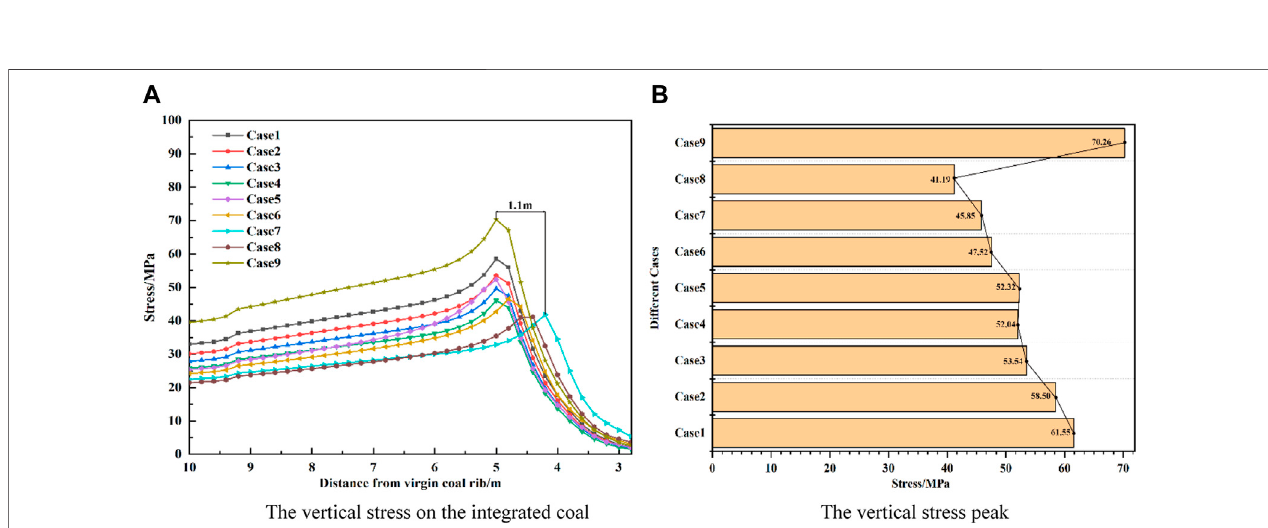
Frontiers in Earth Science |